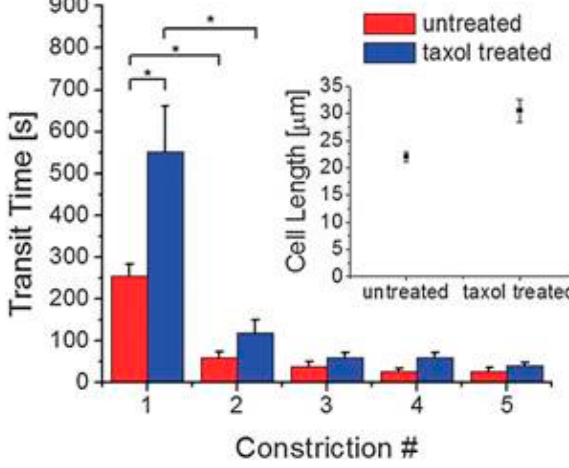
Figure 5. Cell permeation across sequential microfluidic constriction channels with the effects of taxol investigated. Cells treated with taxol were larger (inset) and required a longer transit time to cross the first constriction than untreated cells. For both cell groups, the initial transit required the longest time while subsequent transits were faster where the duration difference between the two cell groups was reduced. Reproduced with permission from [44].